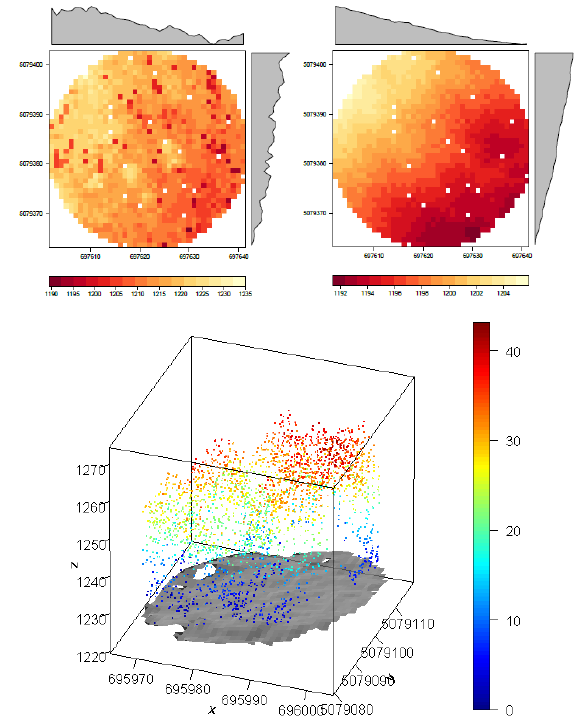
Figure 5. Profiles showing the vertical distribution FW peaks in four different